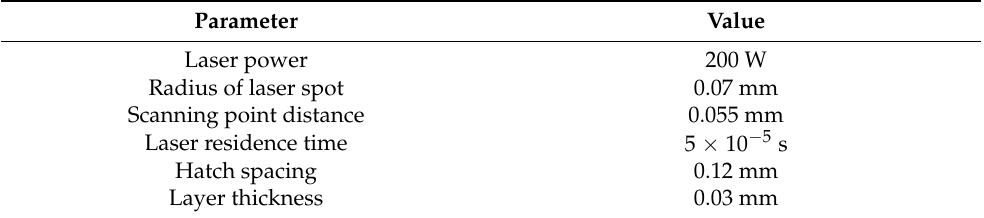
Table 2. The process parameters of both simulations and the